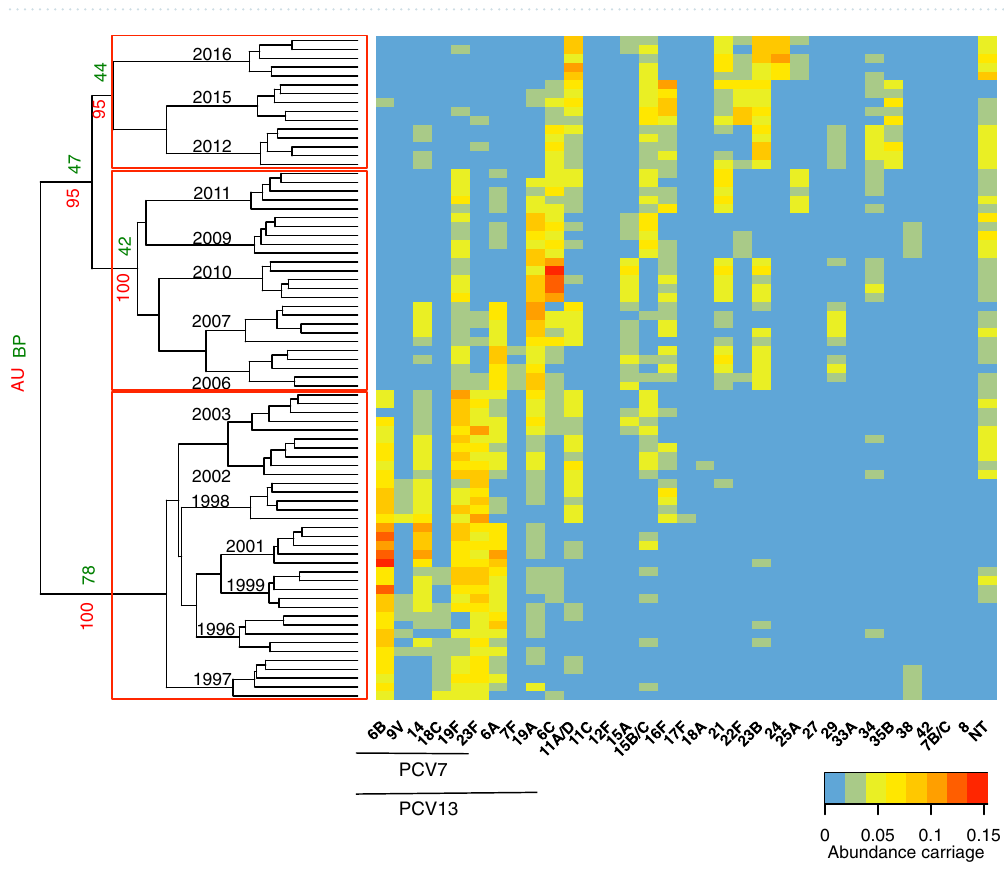
Figure 5. Profiles of pneumococcal serotype communities. Dendrogram (left) depicting the hierarchical clustering of the Bray–Curtis similarity indexes of pneumococcal serotype communities in each year. Three clusters were identified and are highlighted in red. Heatmap (right) shows the relative abundance of each serotype. Green numbers close to dendrogram branches indicate bootstrap probability (BP); red numbers close to dendrogram indicate approximately unbiased P (AU); black numbers indicate study